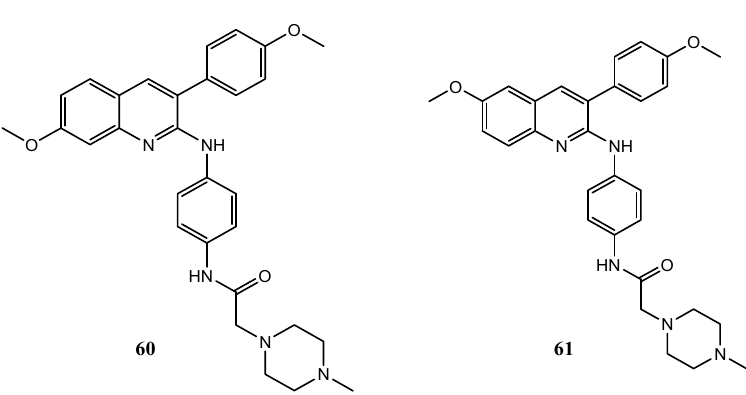
Figure 33. Structure of 3-aryl-quinoline derivatives 60 and 61 , dual VEGFR-2 / ER α inhibitors [136].